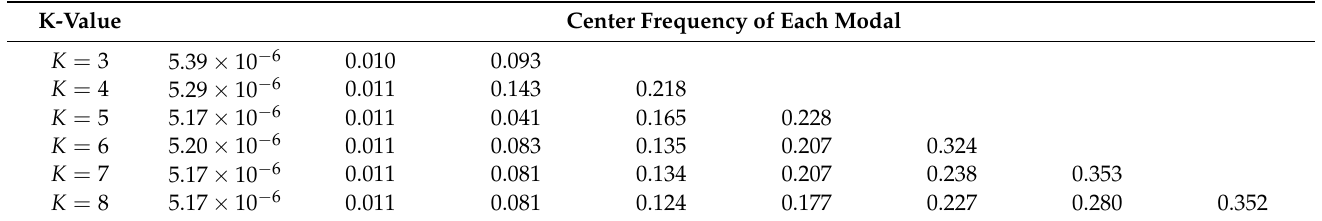
Table 3. Center frequency of each modal in dataset B.